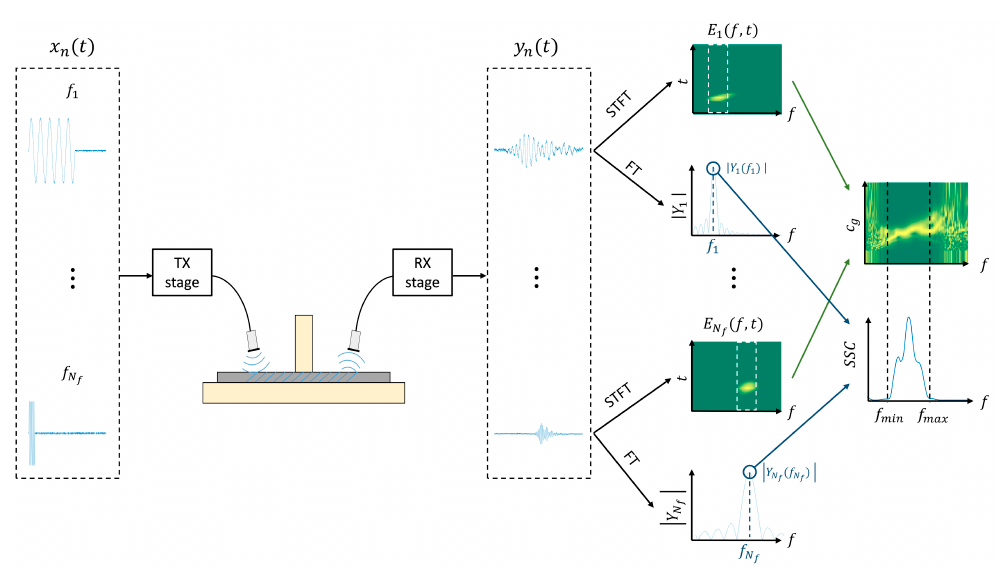
Figure 4. Diagram of the system sensitivity curve ( SSC ) and the combined spectrogram